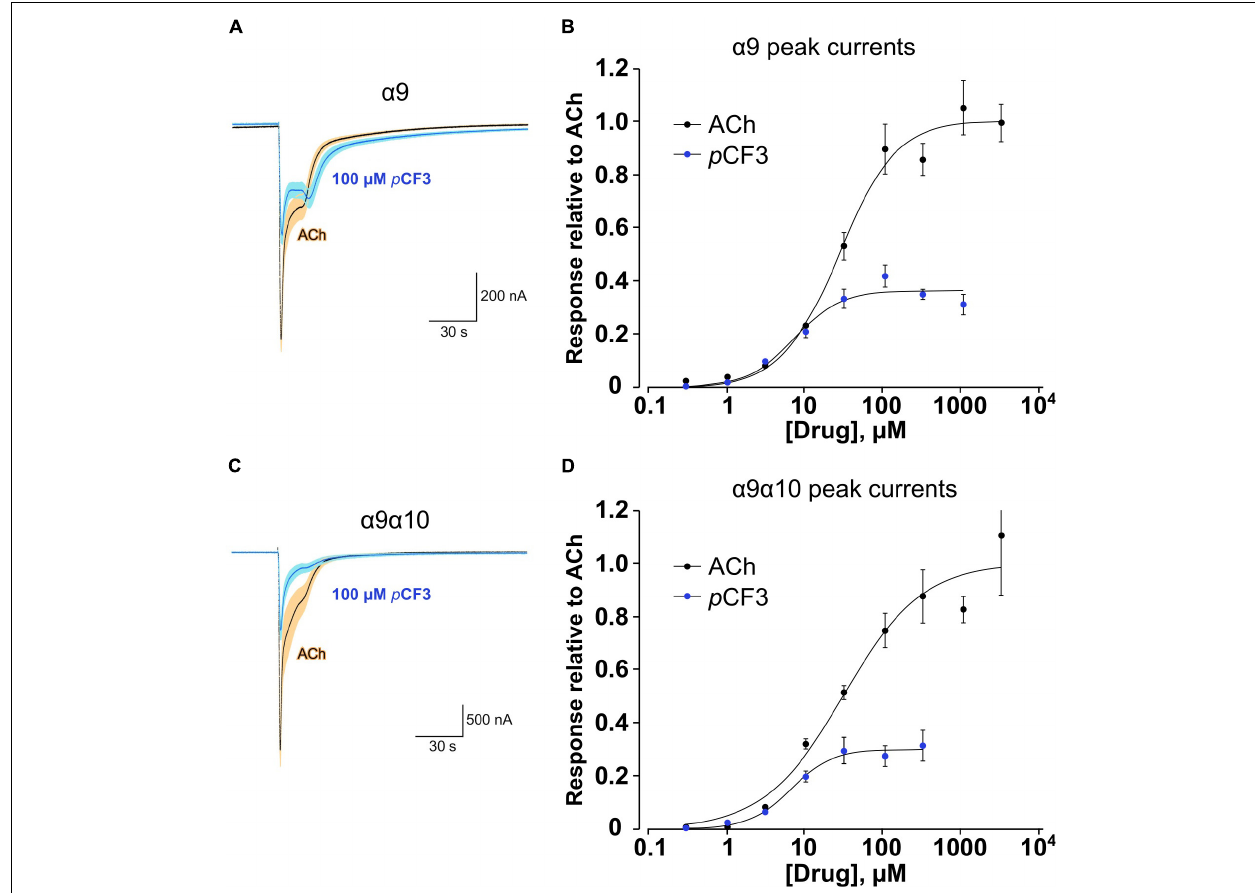
FIGURE 7 | Concentration-response studies for acetylcholine (ACh) and p CF3-diEPP ( p CF3) on heterologously expressed human nAChR subunits α 9 and α 9 α 10. Two-electrode voltage-clamp measurements were performed on Xenopus laevis oocytes heterologously expressing human α 9 or α 9 α 10 nAChR. (A,C) Averaged responses of oocytes expressing α 9 nAChR (A, n = 6) or nAChR α 9 α 10 [ (C) n = 5] to 60 µ M ACh in the absence and the presence of 100 µ M p CF3. Individual cell responses were scaled to the peak amplitude of the ACh controls, then averaged (dark blue line) and plotted with the calculated SEM at each point (light blue band). These are compared to the averaged responses (black lines) and SEMs (tan bands) of the ACh control responses. (B) Average peak-current responses to ACh, normalized to the ACh maximum response of cells expressing subunit α 9, compared to responses to p CF3 ( n = 7). The p CF3 currents were initially measured relative to 60 µ M ACh controls obtained prior to the p CF3 applications and then adjusted for the ratio of the ACh controls to ACh maximum by multiplying the values by 0.63. With the ACh I Max = 1, the EC 50 was 26.1 ± 4.2 µ M (Chisq = 0.017, R = 0.9942). For p CF3, the I Max was 0.36 ± 0.02 and the EC 50 was 7.0 ± 1.9 µ M (Chisq = 0.007, R = 0.979). (D) Similar experiments as described in (B) were performed on oocytes heterologously expressing α 9 α 10 nAChRs. With the ACh I Max = 1, the EC 50 was 29.7 ± 9.9 µ M (Chisq = 0.037, R = 0.986). For p CF3, the I Max was 0.30 ± 0.01 and EC 50 was 6.4 ± 0.9 µ M (Chisq = 0.001, R = 0.995). For all concentration-response studies, the applications of the test compounds (ACh or p CF3) at progressively higher concentrations were alternated by repeated application of ACh at the control concentration of 60 µ M to confirm that there was no rundown of the ACh controls through the course of the